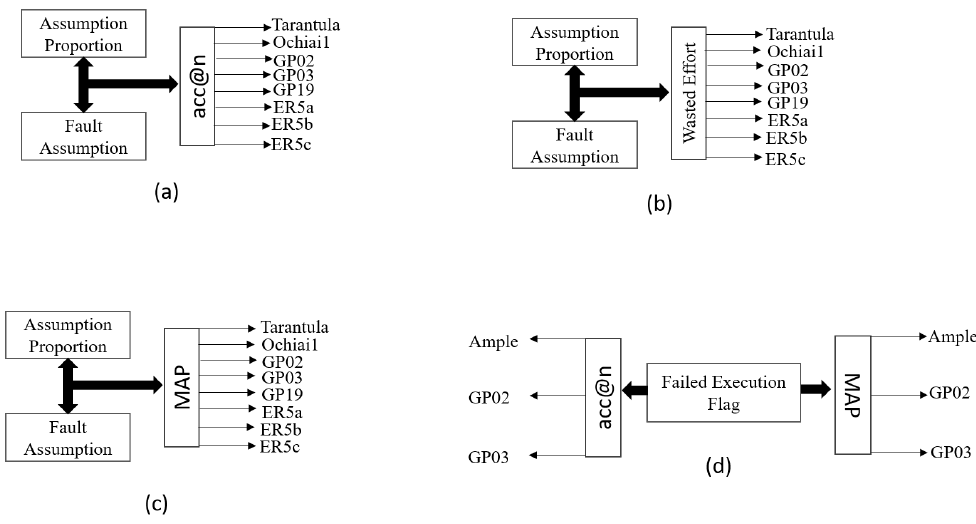
Figure 3. The improvements of the defined metrics on the existing formulas. ( a ) the list of formulas that can be improved in terms of acc@n when combined with Fault Assumption or Assumption Proportion. ( b ) the list of formulas that Fault Assumption or Assumption Proportion can enhance their wasted effort. ( c ) the formulas that can be improved in terms of MAP when combined with Fault Assumption or Assumption Proportion. ( d ) the list of the formulas that Failed Execution Flag can enhance in terms of acc@n and